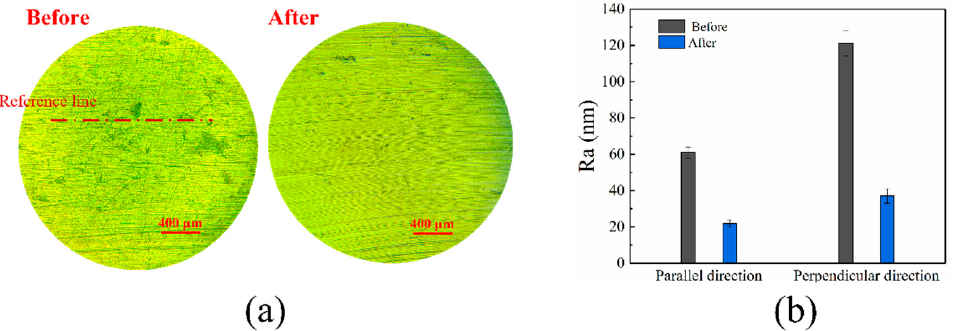
Figure 8. Surface morphology ( a ) and surface roughness ( b ) of brass workpiece polished for 2 h by alumina-doped titanium dioxide ER polishing fluid (rotation speed = 200 r/min, voltage = 3 kV, machining gap = 0.5 mm).